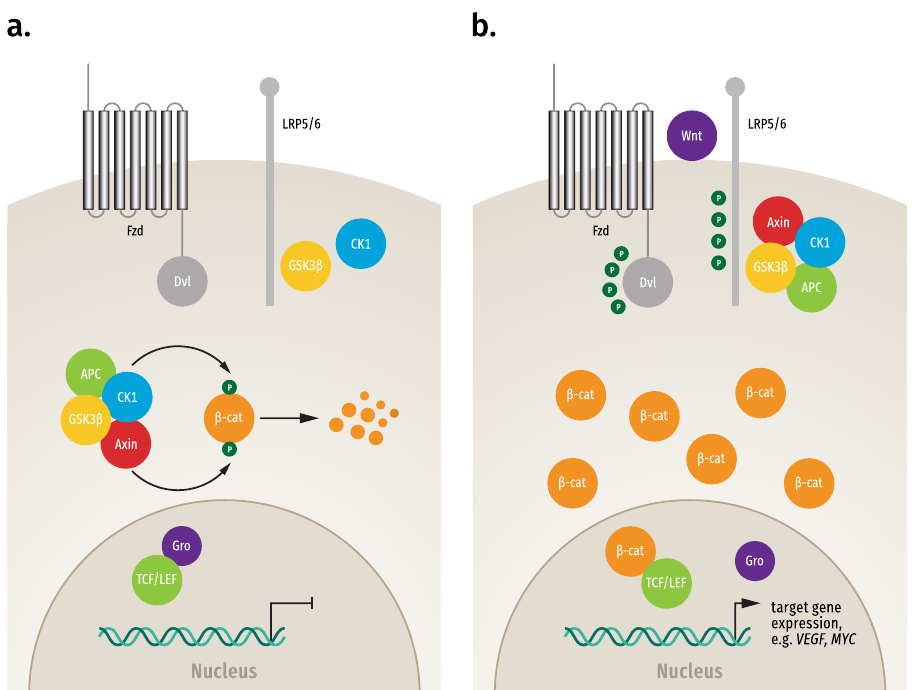
Fig. 1 Wnt/ β -catenin signaling pathway. a In the absence of Wnt ligands, β -catenin ( β -cat) in the cytosol is bound and processed by a destruction complex, comprising Axin, adenomatous polyposis coli (APC), glycogen synthase kinase 3 β (GSK3 β ), and Casein kinase 1 (CK1). β -cat is sequentially phosphorylated (P) by CK1 and GSK3 β and targeted for degradation, maintaining low levels of cytosolic β -cat. In the absence of Wnt signaling, the T-cell factor/lymphoid enhancer factor (TCF/LEF) family of transcription factors interact with Groucho (Gro) proteins and together act to repress gene expression. b In the presence of Wnt ligands, extracellular Wnt binds to Frizzled (Fzd) and low- density lipoprotein receptor-related proteins 5 and 6 (LRP5/6) at the cell membrane, inducing phosphorylation of LRP5/6. Subsequently, Disheveled (Dvl) and Axin are recruited to the membrane, thereby inactivating the destruction complex. As a result, β -cat accumulates in the cytosol and translocates to the nucleus where it binds with TCF/LEF, displaces Gro, and activates expression of target